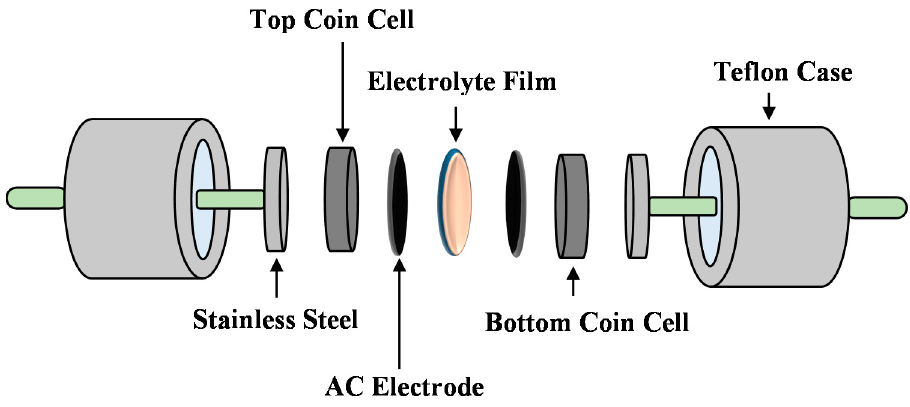
Figure 2 . Illustration of the fabricated electrochemical double-layer capacitor (EDLC). Figure 2. Illustration of the fabricated electrochemical double-layer capacitor